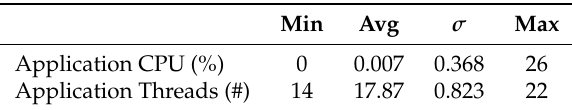
Table 4. ADB “top”